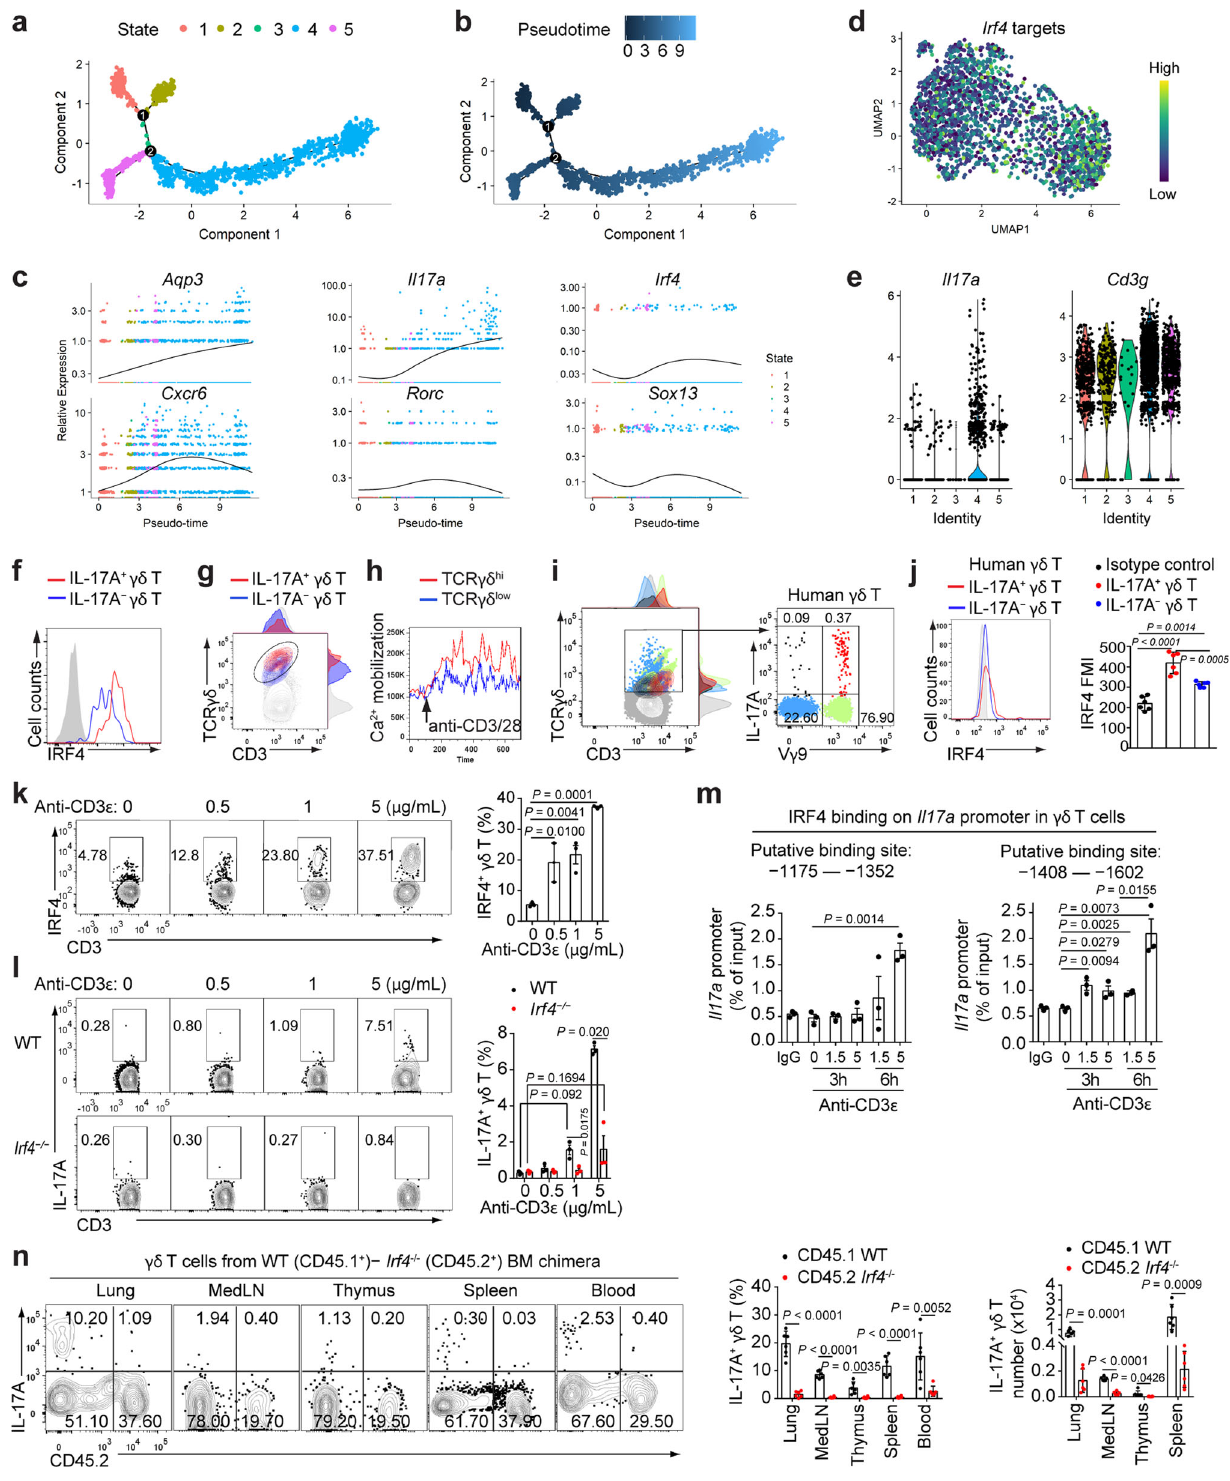
involvement of endogenous lipids in mediating γδ T cell activation and IL-17A production via CD1d-dependent presentation. γδ T cell IL-17A production requires CD1d-dependent antigen presentation . To identify the key cellular components acting as lipid antigen-presenting cells for γδ T cell activation, we exam- ined CD1d expression on different immune cell types in the lung tissue of pdmH1N1-infected mice and found most highly